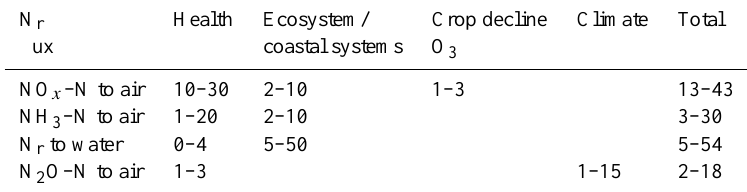
Table 3. Societal costs of nitrogen emissions in ranges based on Brink et al. (2011). Units are EUR(kg N r ) − 1 . N